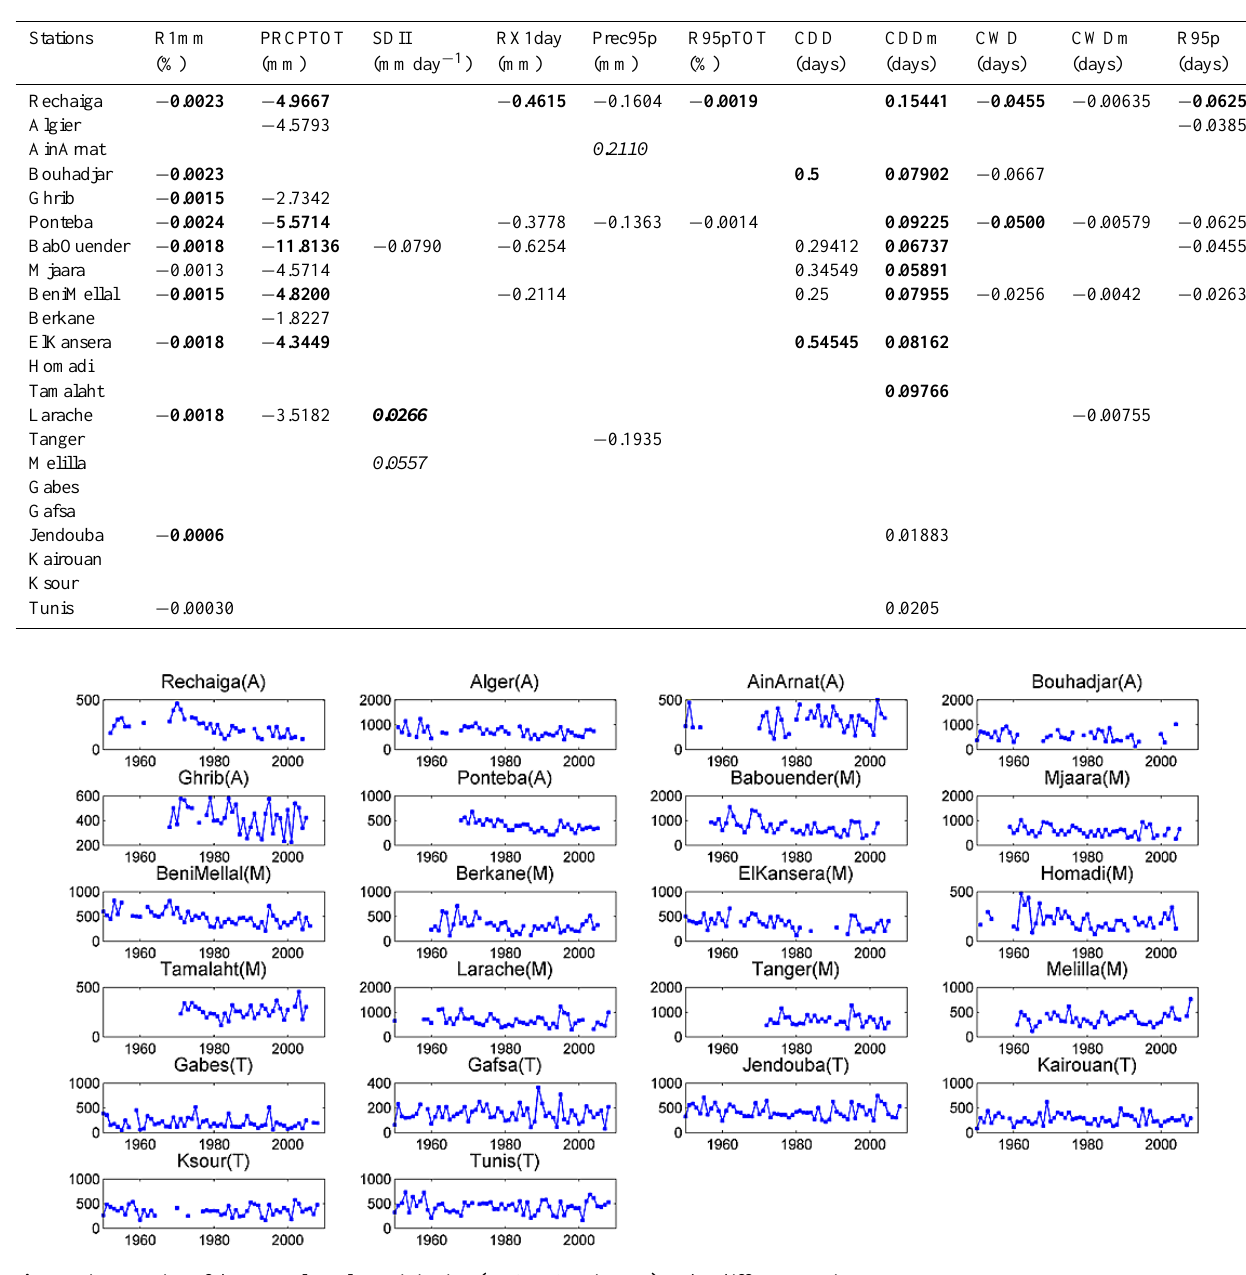
Table 2. Sen slope estimates for each station and each index, only in cases when the Mann–Kendall test detected a significant trend at the local 5% level. Among them, the field-significant trends at the global 5% level are in bold. In italic are indicated the trends towards wetter conditions, all other numbers are the trends towards drier conditions.